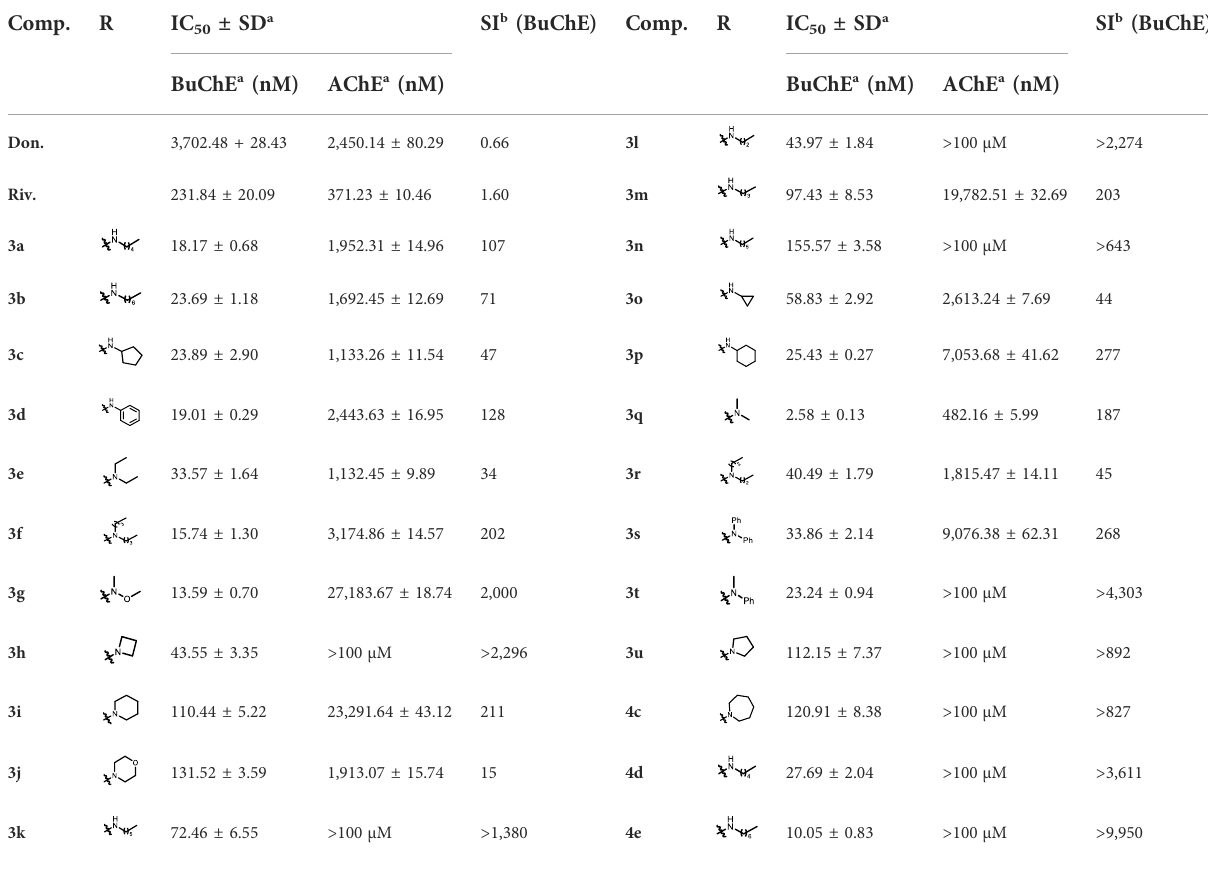
TABLE 2 AChE and BuChE inhibitory activity (IC 50 ) of compounds 3a-3u, 4c-4e. Comp.